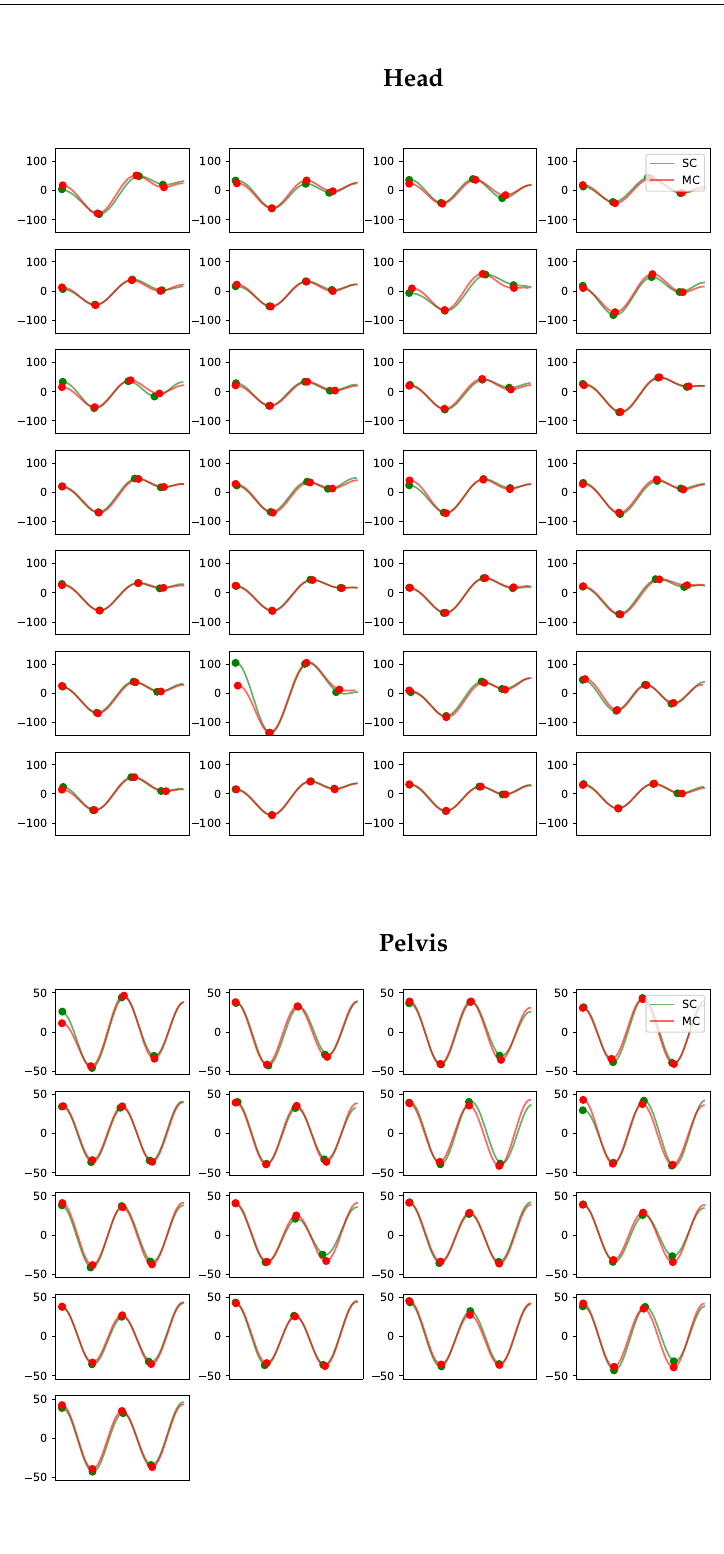
Figure A5. Vertical displacement signals per stride for the head and pelvis for horse 5. Each subplot contains the matched stride segments for the single-camera markerless system (SC) in green and the multi-camera marker-based system (MC) in red. The y-axis shows the vertical displacement in millimeters. The four dots on each curve indicate the positions of the two peaks and two valleys extracted using the approach in Section